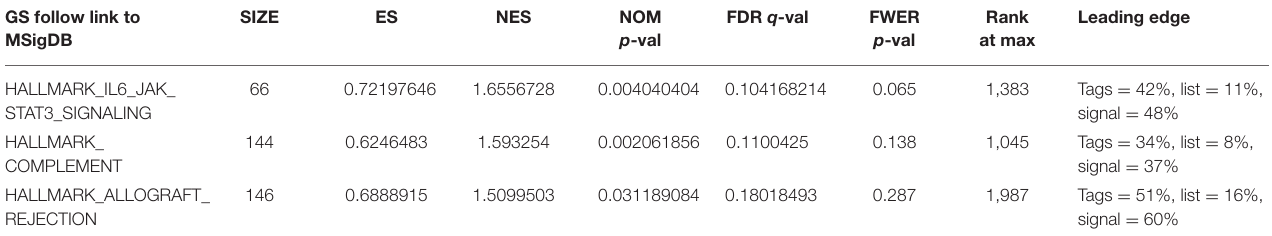
TABLE 4 | Gene Set Enrichment Analysis (GSEA) group by score.